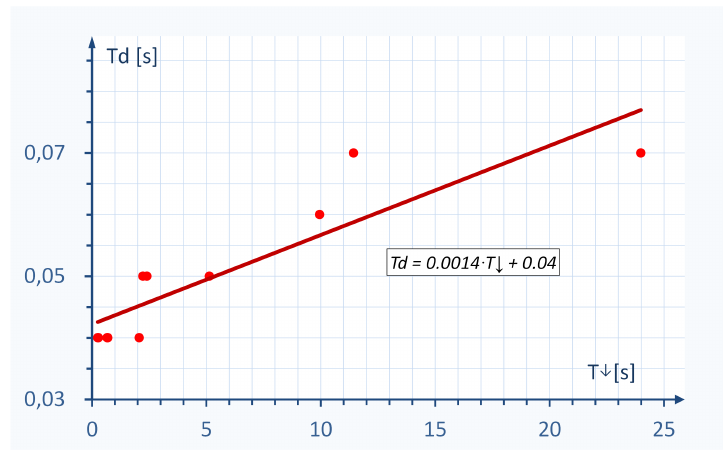
Figure 15. The derivative time, T d , versus the time constant, T ↓ .